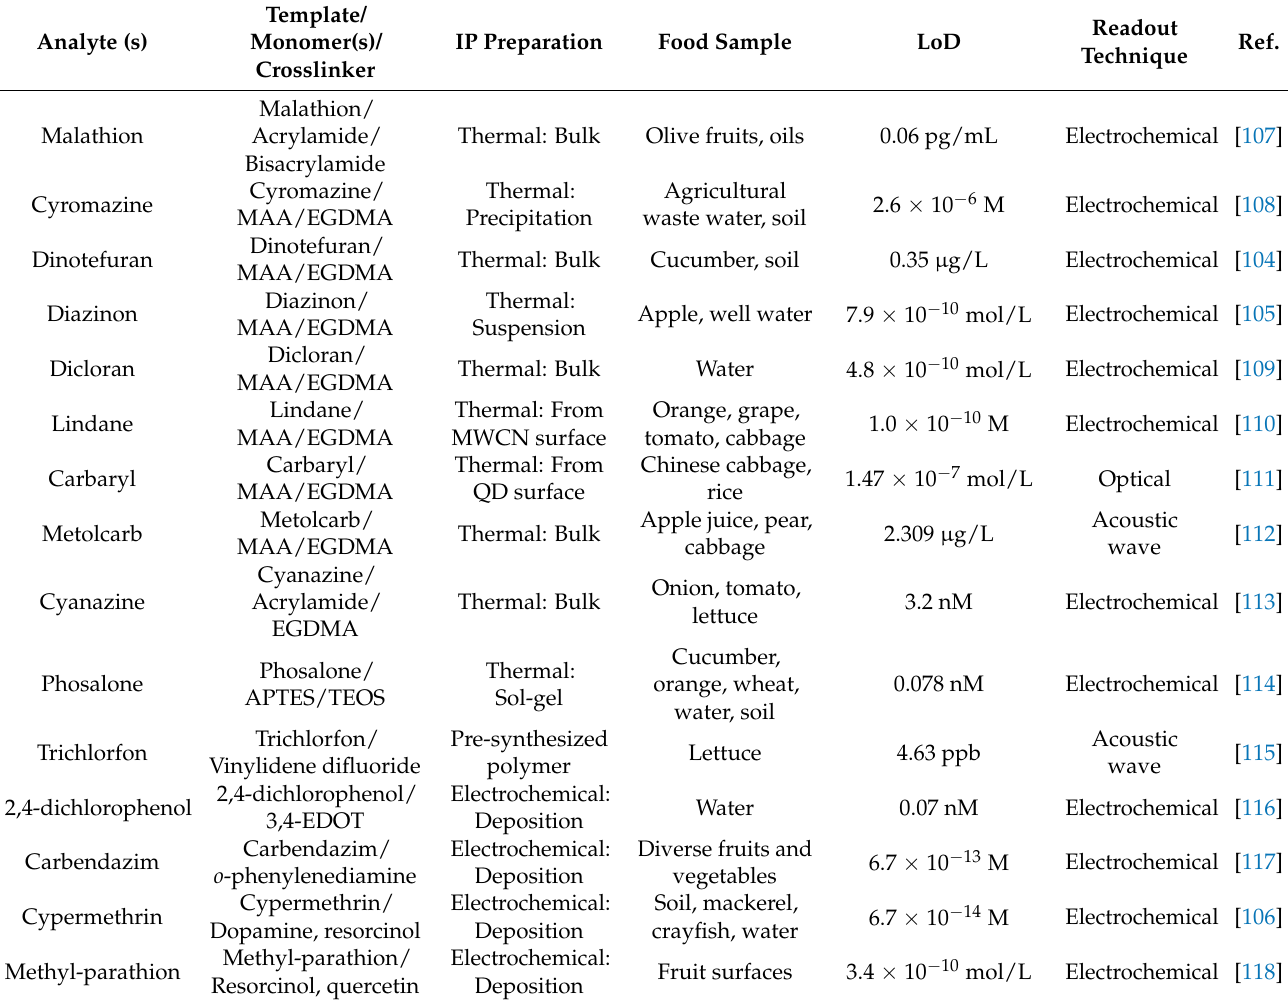
Table 1. Summary of recent publications for the recognition of pesticides using IPs in food